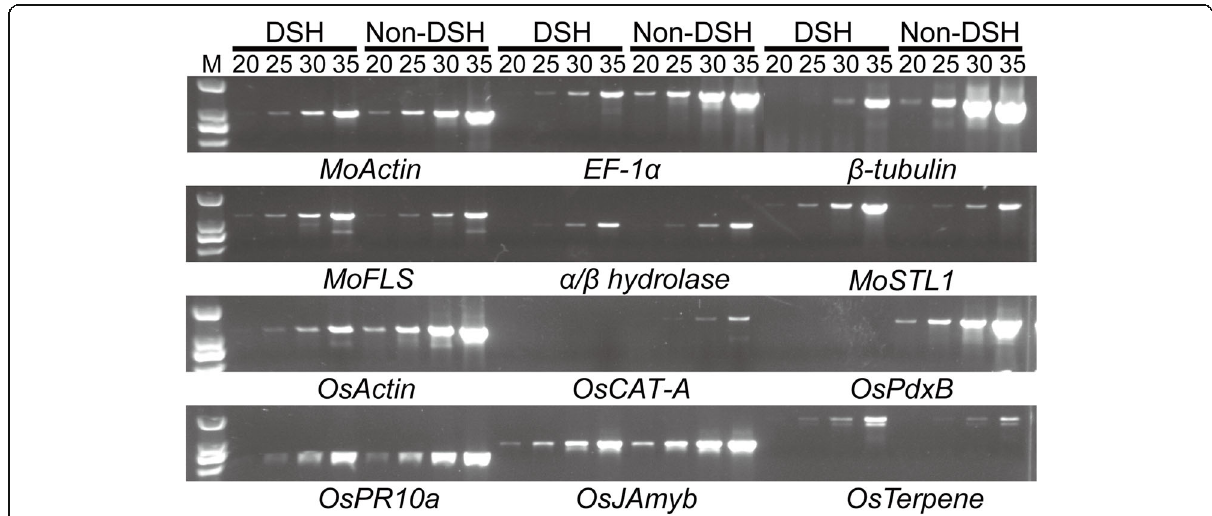
Fig. 3 Constitutive genes were greatly suppressed and upregulated genes were enriched and normalized by DSH. Using DSH and Non-DSH treated products as templates, constitutive genes ( MoActin , EF-1 α , β -tubulin , OsActin , OsCAT-A , OsPdxB ) and upregulated genes ( MoFLS , α / β hydrolase , MoSTL1 , OsPR10a , OsJAmyb , OsTerpene ) were amplified with gene-specific primers. Aliquots of PCR reaction mixture were taken at 20, 25, 30, and 35 cycles of amplification and the products were analyzed on 1% agarose gels as indicated. “ DSH ” represents products treated by DSH, and “ Non-DSH ” indicates samples without DSH treatment as a control. Lane M, DNA ladder (Generay. Code No. 1705G22) length were extracted from the gel and introduced into the expression binary vector pCBDEST-transient (Additional file 3: Figure S3) to construct the expres- sion library I through consecutive BP and LR reactions of the Gateway® cloning procedure (Fig. 1b). To obtain (II) was constructed with cDNA inserts over 1.5 kb in